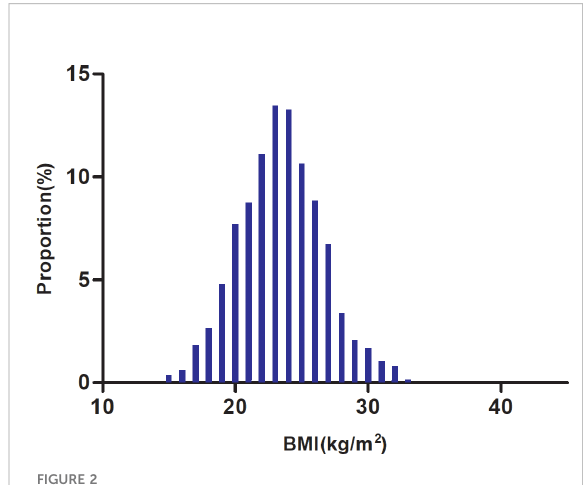
FIGURE 2 Distribution of BMI. It presented a normal distribution, ranging from 14.57 to 33.06 kg/m 2 , with a mean of 23.44 kg/m 2 .